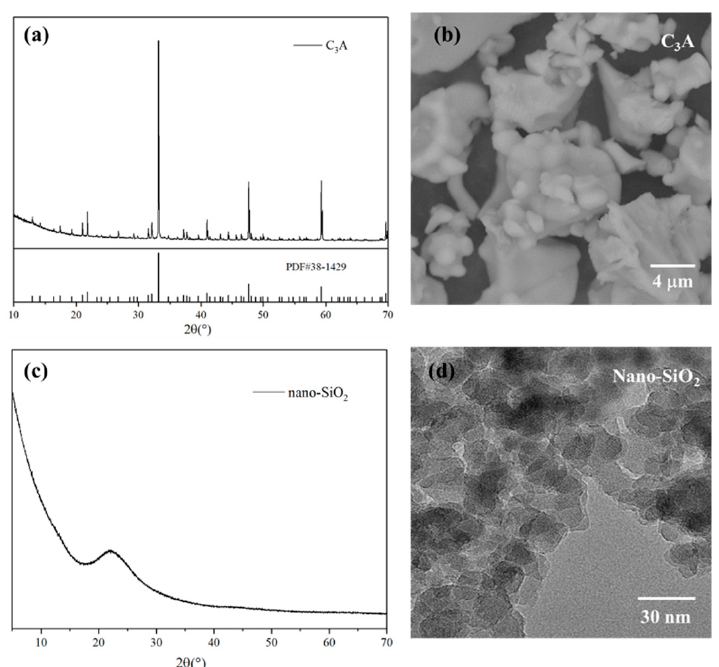
Figure 1. Mineral composition and particle characteristics of pure C 3 A and nano-SiO 2 measured by ( a ) XRD diffraction pattern of pure C 3 A; ( b ) SEM photograph of C 3 A; ( c ) XRD diffraction pattern of nano-SiO 2 ; ( d ) TEM photograph of nano-SiO 2 .